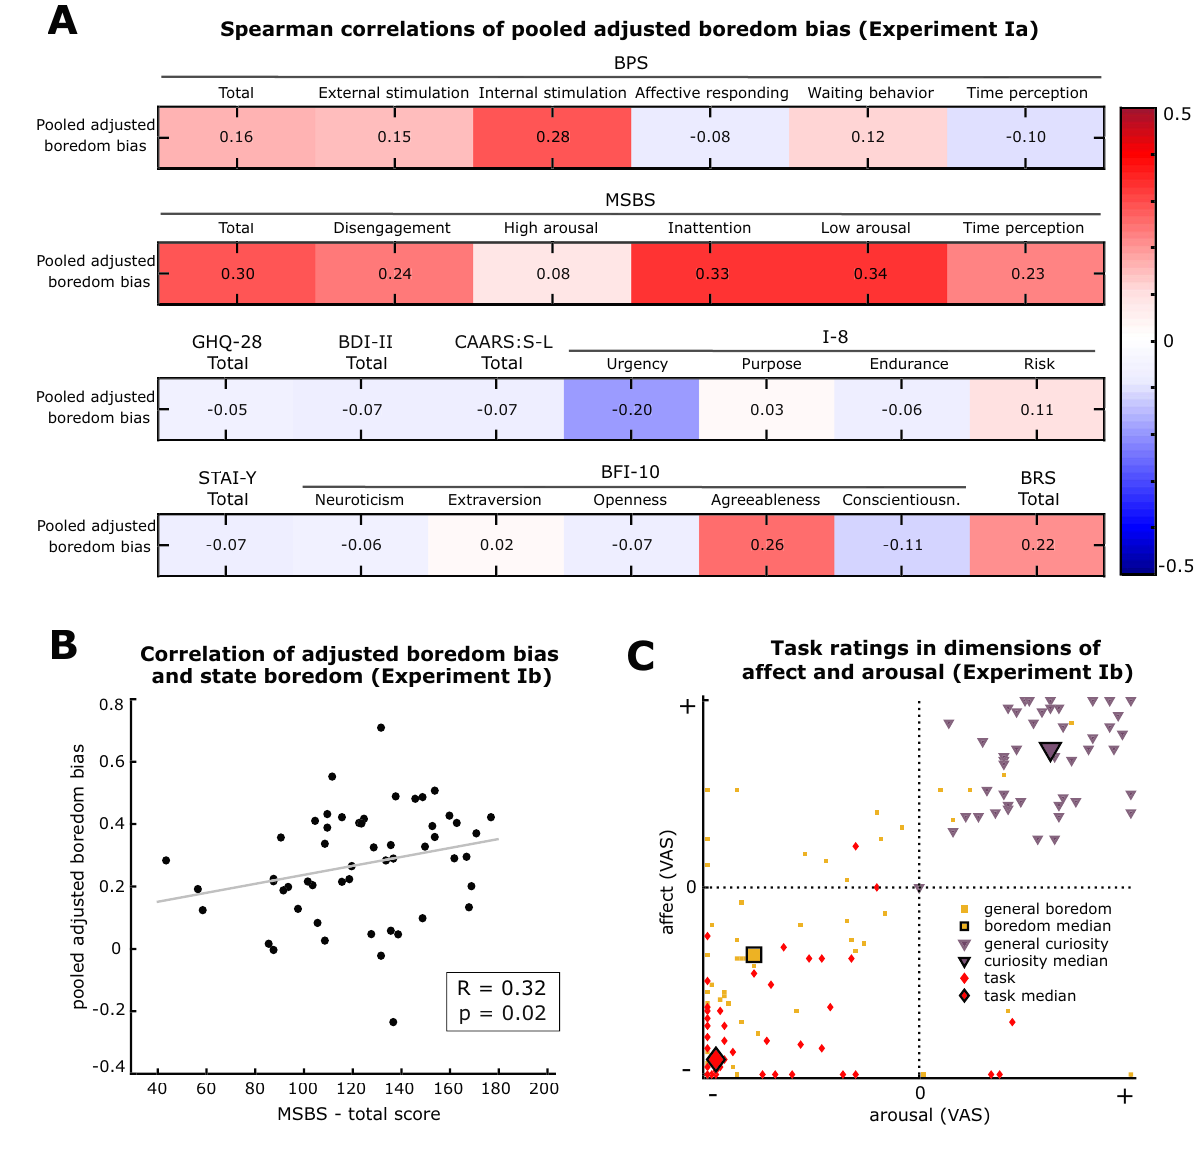
Figure 3. Construct validation of the Boredom Choice Task: ( A ) Exploratory investigation of the Spearman correlations between the pooled adjusted boredom bias and the diverse psychometric self-reports ( BPS Boredom Proneness Scale, MSBS Multidimensional State Boredom Scale, GHQ-28 General Health Questionnaire, BDI-II Beck’s Depression Inventory, CAARS:S-L Conner’s Adult ADHD Rating Scale, I-8 Impulsivity Questionnaire, STAI-Y State Trait Anxiety Inventory, BFI-10 Big Five Inventory, BRS Brief Resilience Scale). Each correlation is computed over n = 49 participants from Experiment Ia. The color of each cell displays the magnitude of correlation (R-value). ( B ) Specific correlation analysis with the independent data from Experiment Ib: The scatter plot illustrates the relationship between the pooled adjusted boredom bias of each participant and the corresponding MSBS state boredom report (n = 53 participants; Spearman’s R = 0.32, p = 0.02). The grey line indicates the best linear fit. ( C ) Scatter plot of participants’ visual analog scale (VAS) ratings of affect and arousal for imagined boredom (yellow), imagined curiosity (violet) and the BCT experience (red) (n = 53 participants from Experiment Ib). The large markers indicate the overall median of each